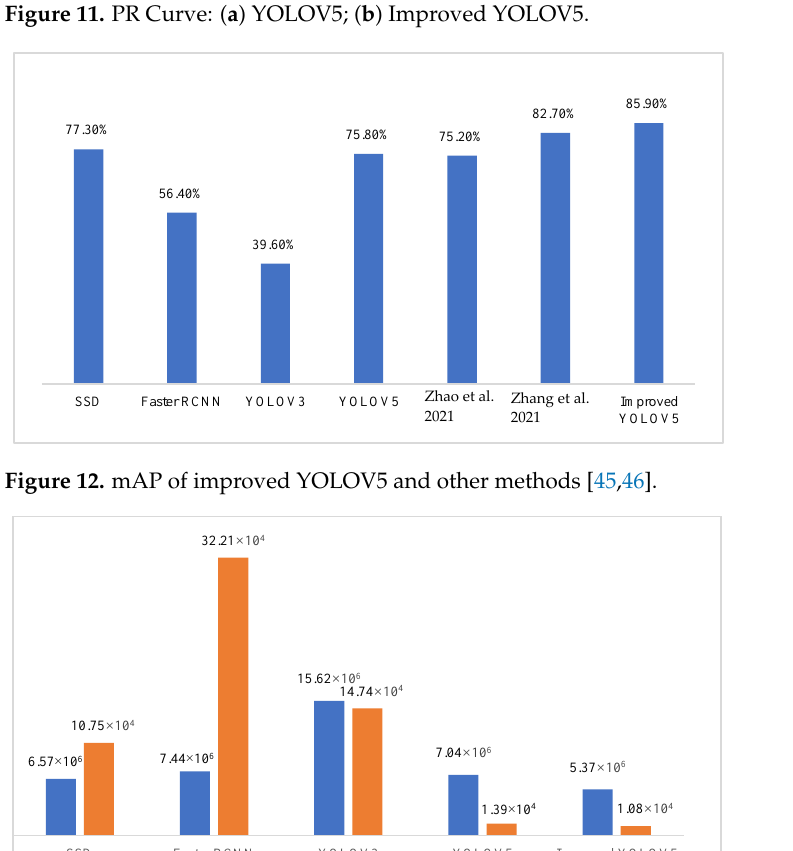
Figure 11. PR Curve: ( a ) YOLOV5; ( b ) Improved YOLOV5.